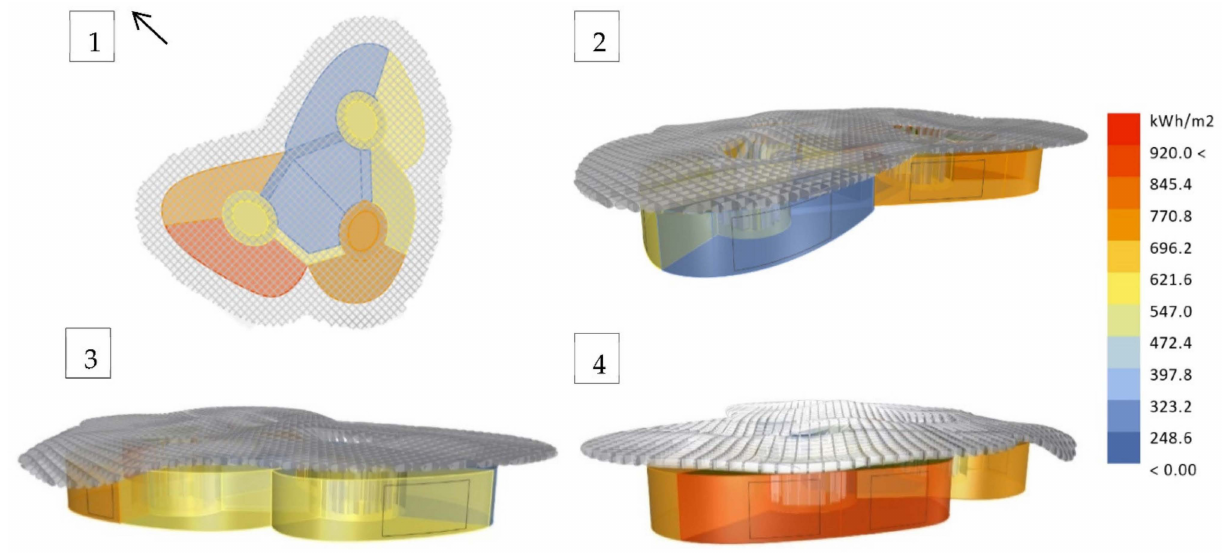
Figure 20. 3D energy model of the new MREIFA design. Figures ( 1 ) top view, ( 2 ) north-east orienta- tion, ( 3 ) east orientation, and ( 4 ) west orientation.